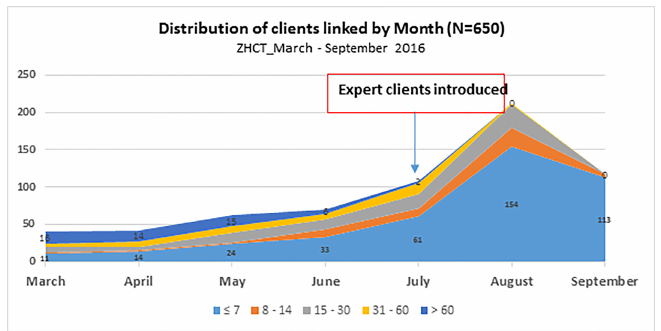
Fig 1. Distribution of clients linked within ZHCT by month and time it took to complete